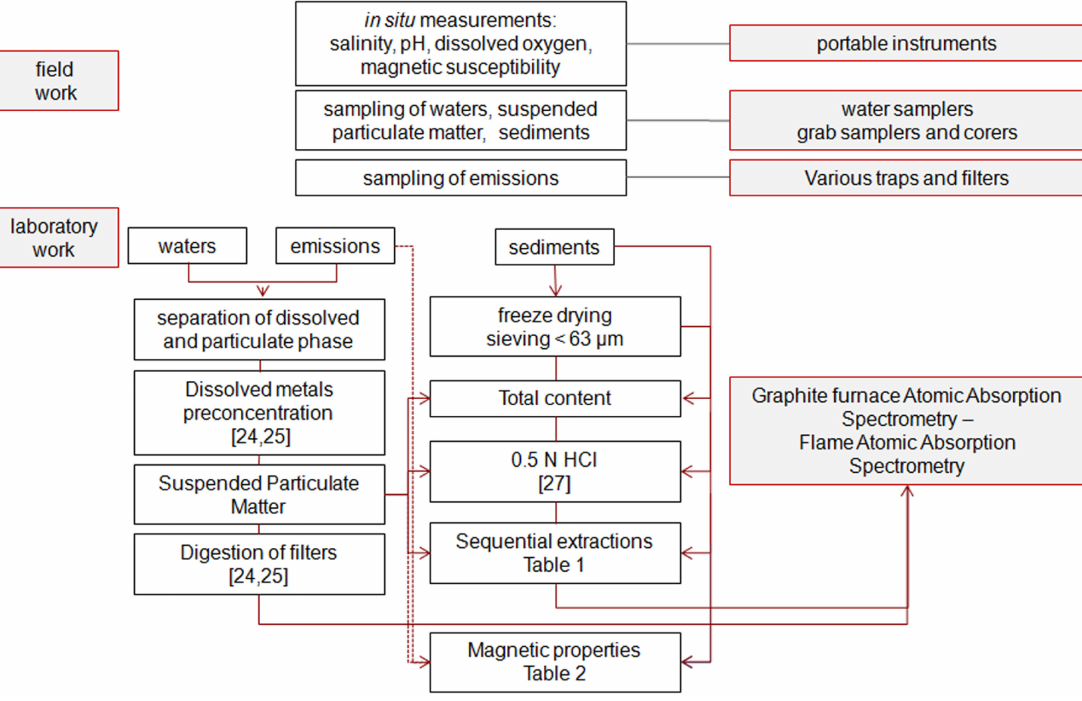
Table 1. Reagents and leachable fractions of metals by Sequential Extraction Schemes.